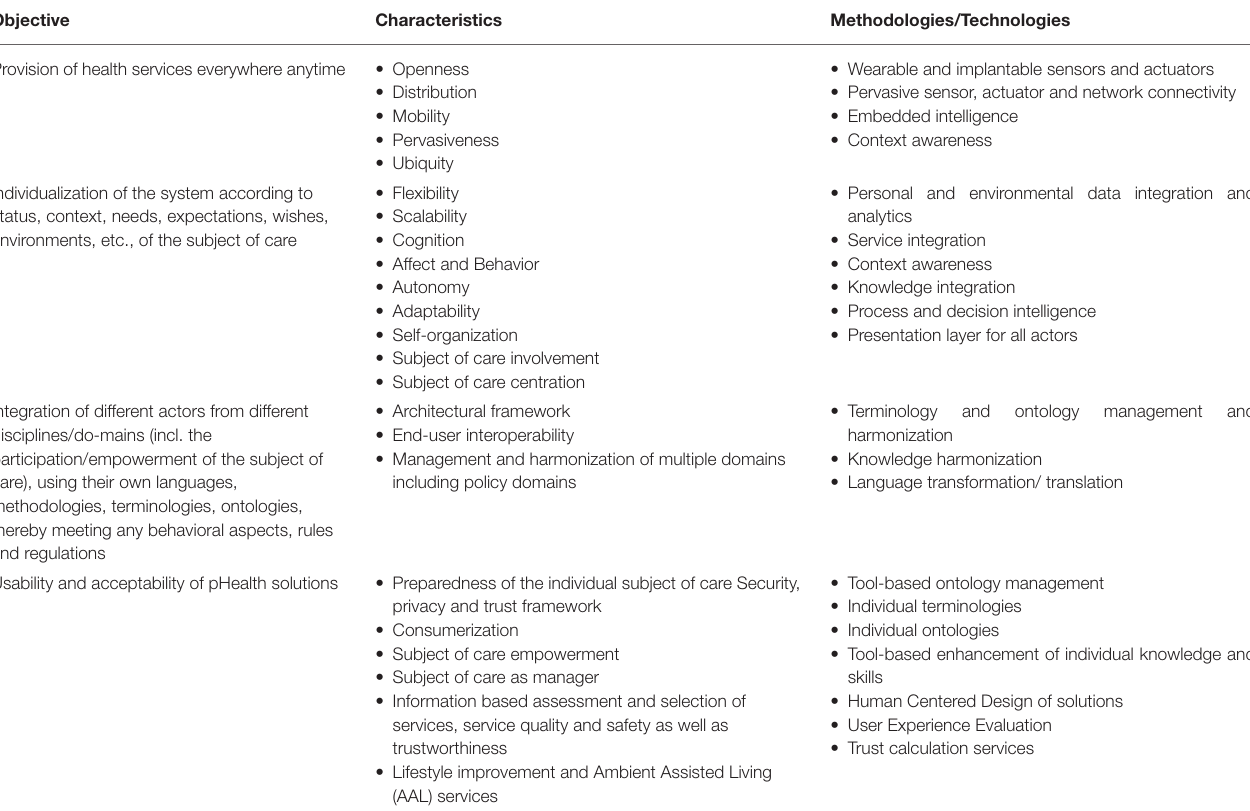
TABLE 1 | PHealth objectives, characteristics and methodologies/technologies to meet objectives